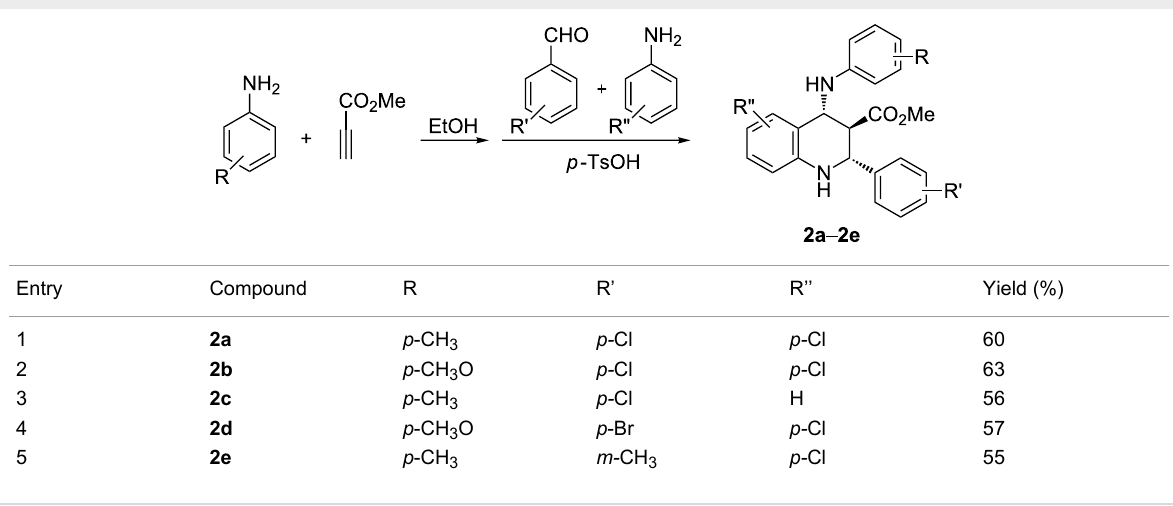
Table 2: Synthesis of functionalized tetrahydroquinolines 2a – 2e